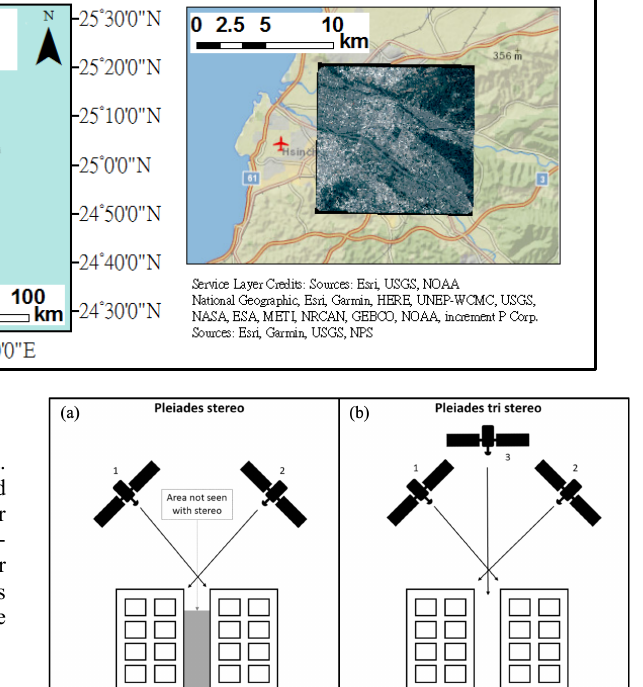
Figure 2. Pleiades VHR (a) stereo and (b) tri stereo satellite imagery (Panagiotakis et al., 2018).